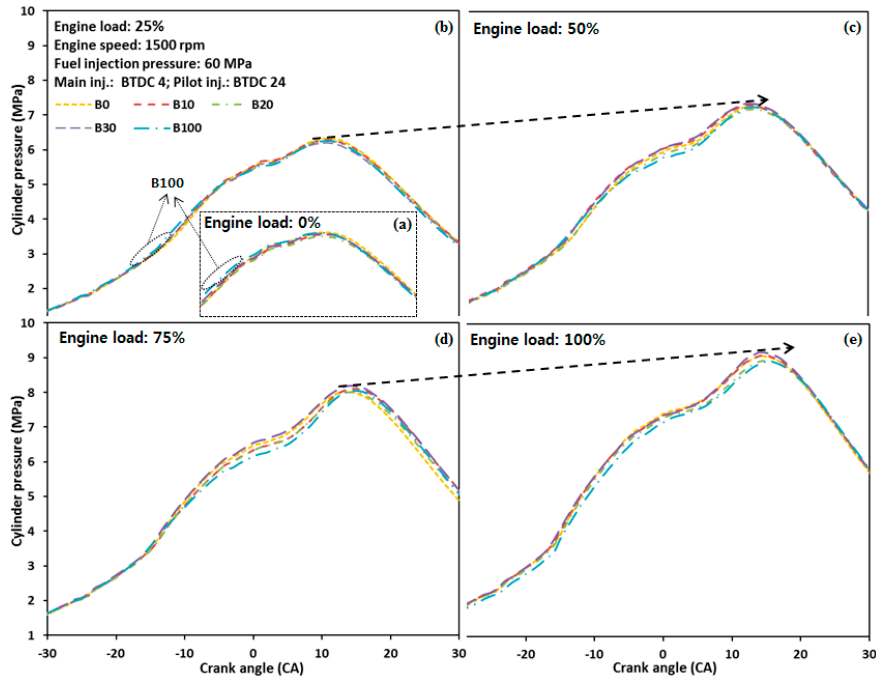
Figure 3. Effect of biodiesel blends on in-cylinder pressure at each engine load. ( a ) Engine load: 0%; ( b ) Engine load: 25%; ( c ) Engine load: 50%; ( d ) Engine load: 75%; ( e ) Engine load: 100%.